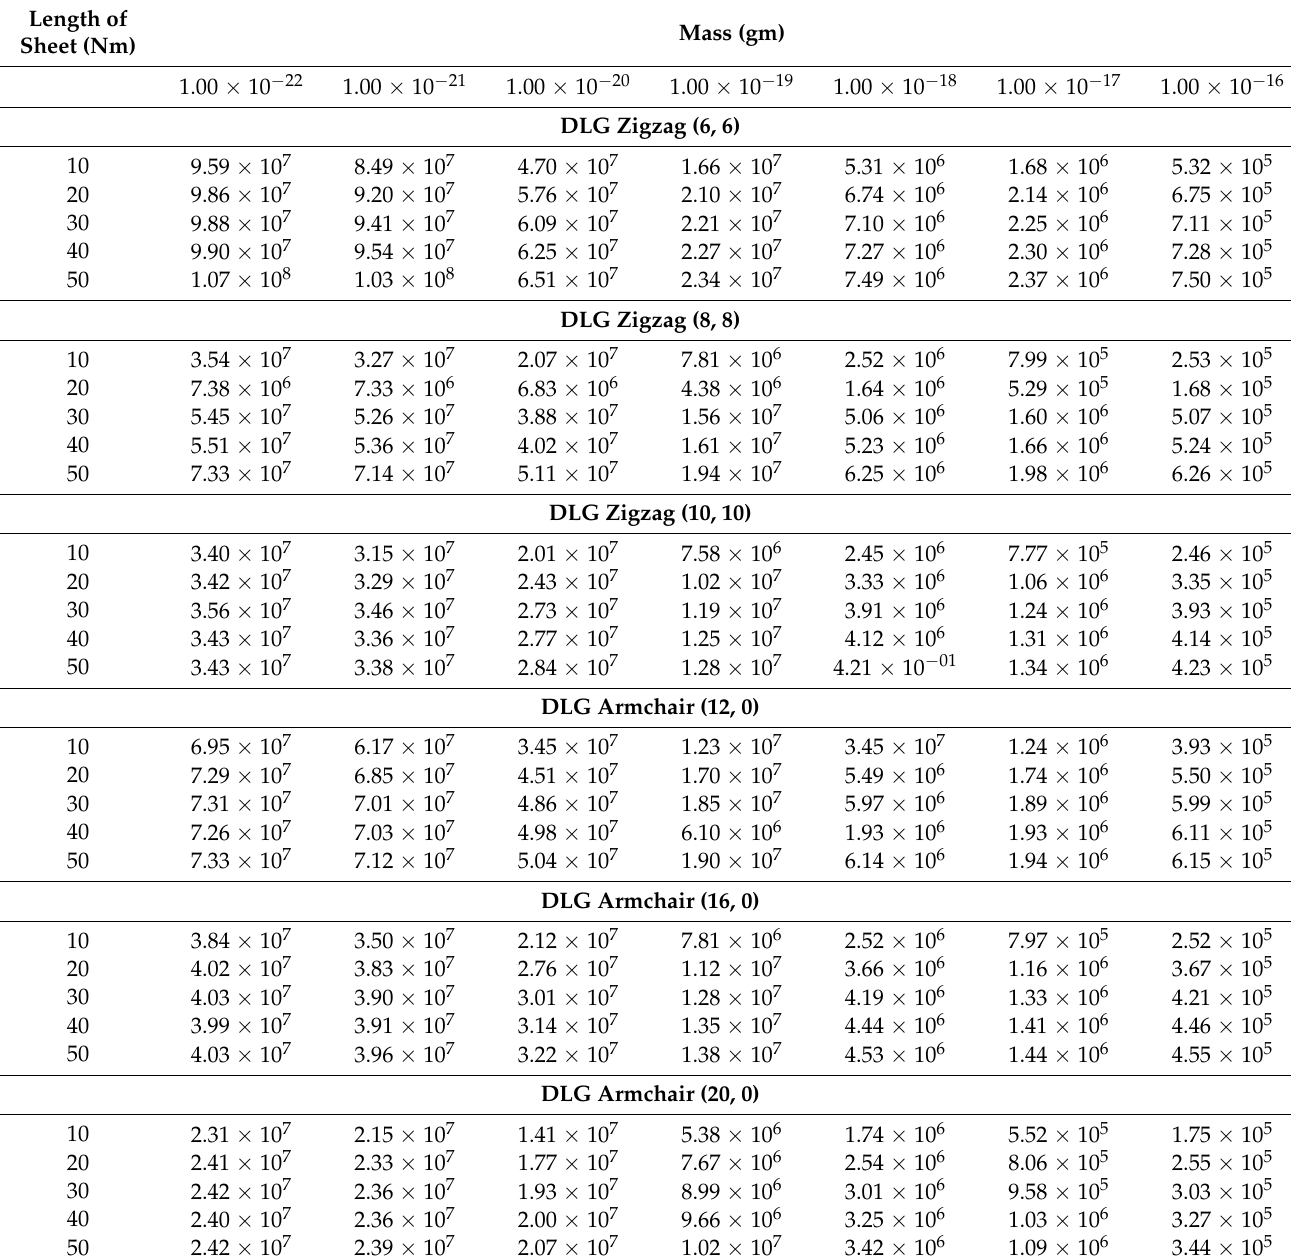
Table 5. Bridged SLG zigzag and armchair with mass addition at centre of